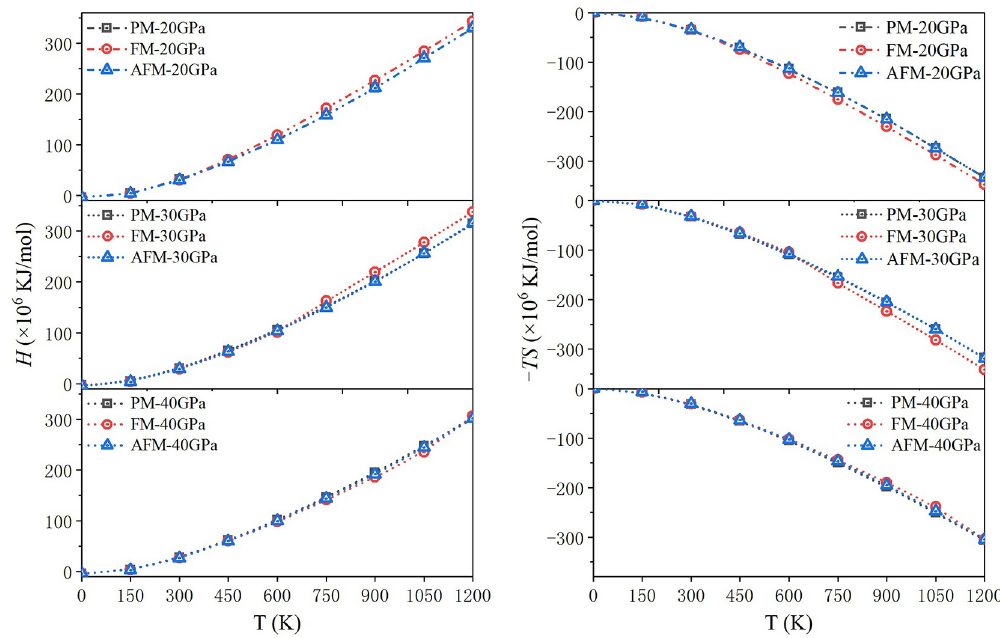
Figure 3. The enthalpy H (T), entropy contribution to free energy − TS (T) of the PM, FM and AFM phases for L1 2 -(Ni,Cu) 3 (Al,Fe,Cr) at 20, 30 and 40